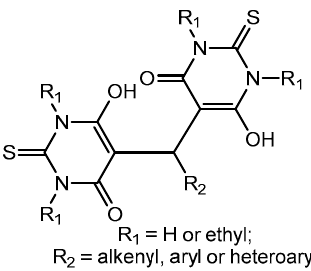
Figure 1. General structure of bis-thiobarbiturates under Figure 29. General structure of bis-thiobarbiturates under study.